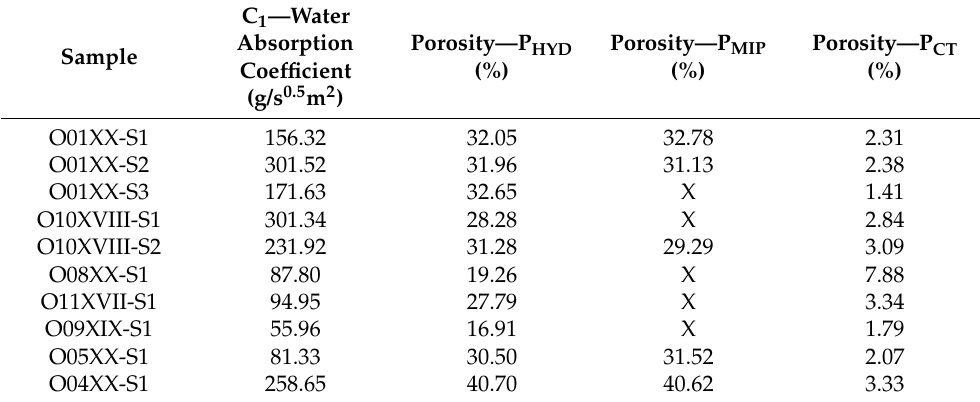
Table 4. Results of water absorption coefficient and porosity determined by hydrostatic method, MIP,